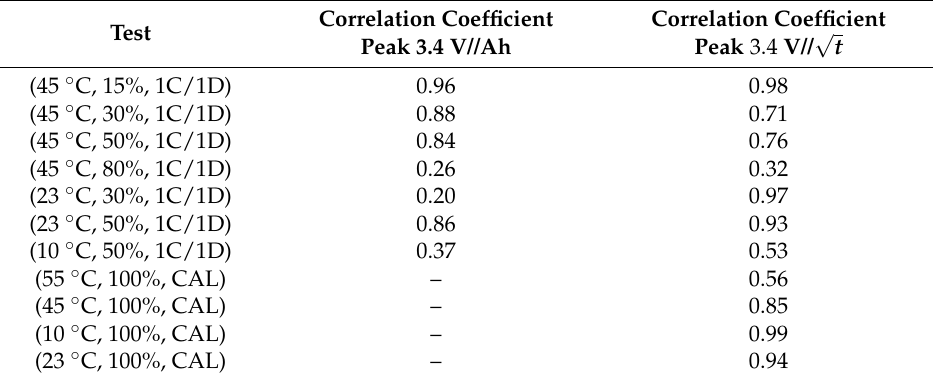
√ t for different tests.